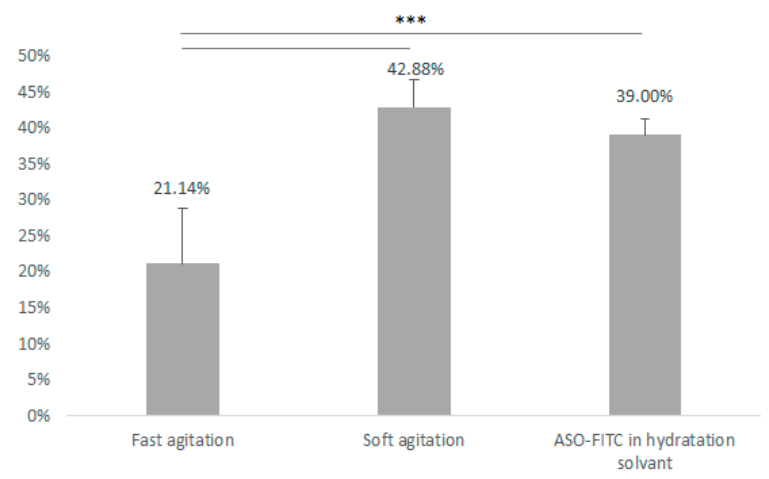
Figure 3. Influence of different strategies on encapsulation rate (***, 0; **, 0.001; * 0.01).